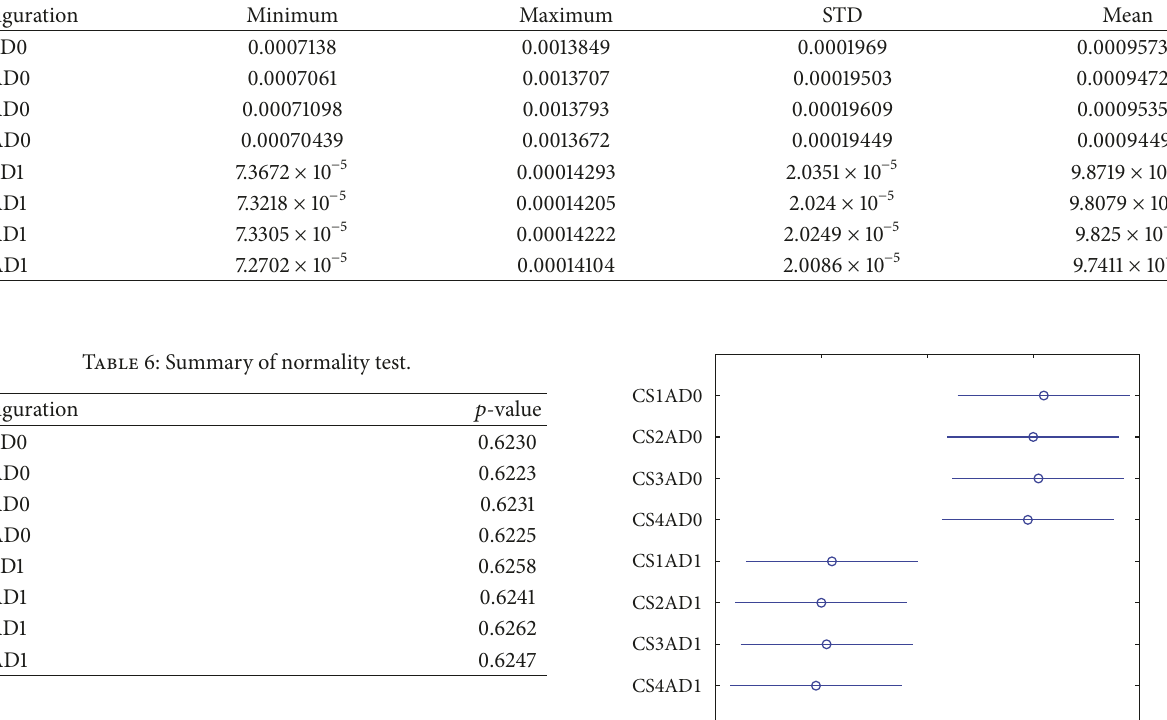
Table 5: Summary of statistical values in the obtained results.